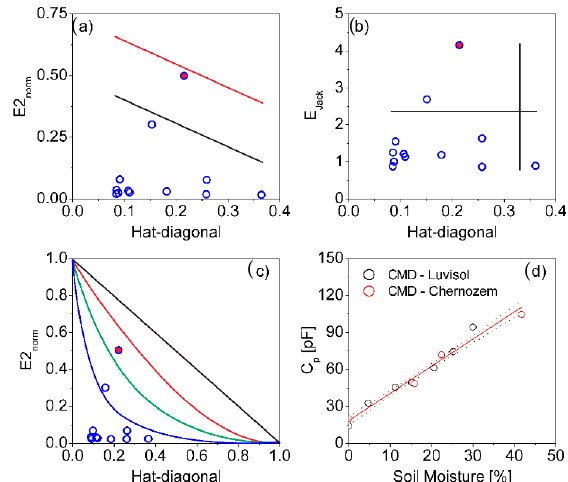
Figure 7. The residual analysis for CMD sensor element presented by ( a ) Pregibon, ( b ) William, and ( c ) the L-R plot, ( d ) regression plot after data filtering for CMD sensor and dataset Luvisol + Chernozem.